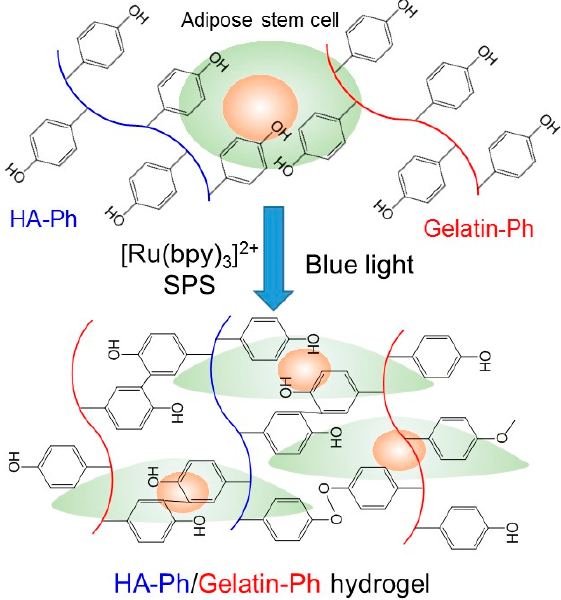
Figure 1. Schematic representation of hyaluronic acid (HA)-Ph/gelatin-Ph hydrogel formation via blue light irradiation in the presence of [Ru(bpy) 3 ] 2+ and sodium ammonium persulfate (SPS).